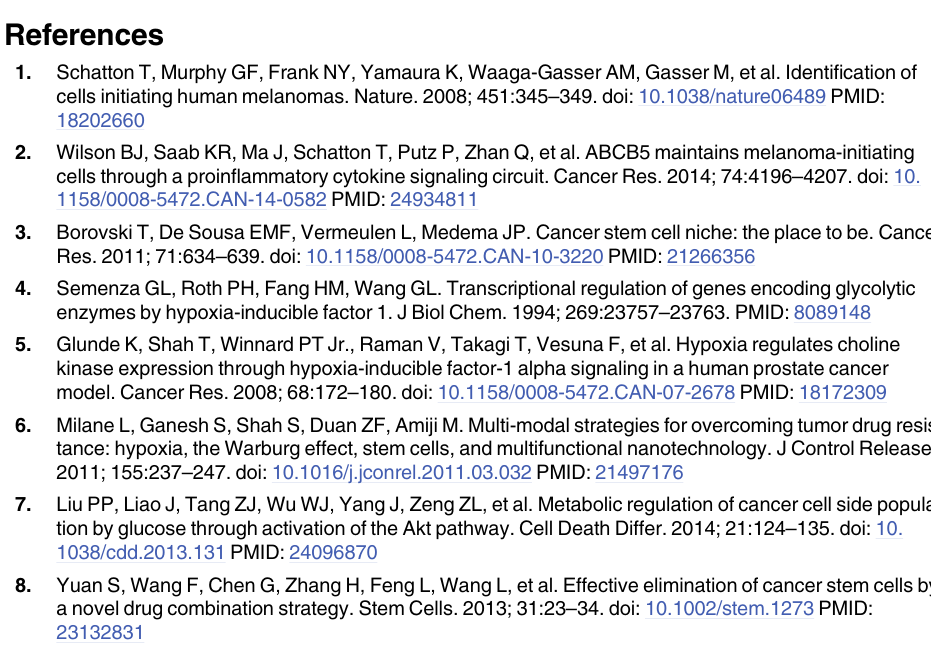
S1 Table. List of NMR chemical shifts used for metabolite analysis and quantification; abbreviations. NMR chemical shifts used for metabolite